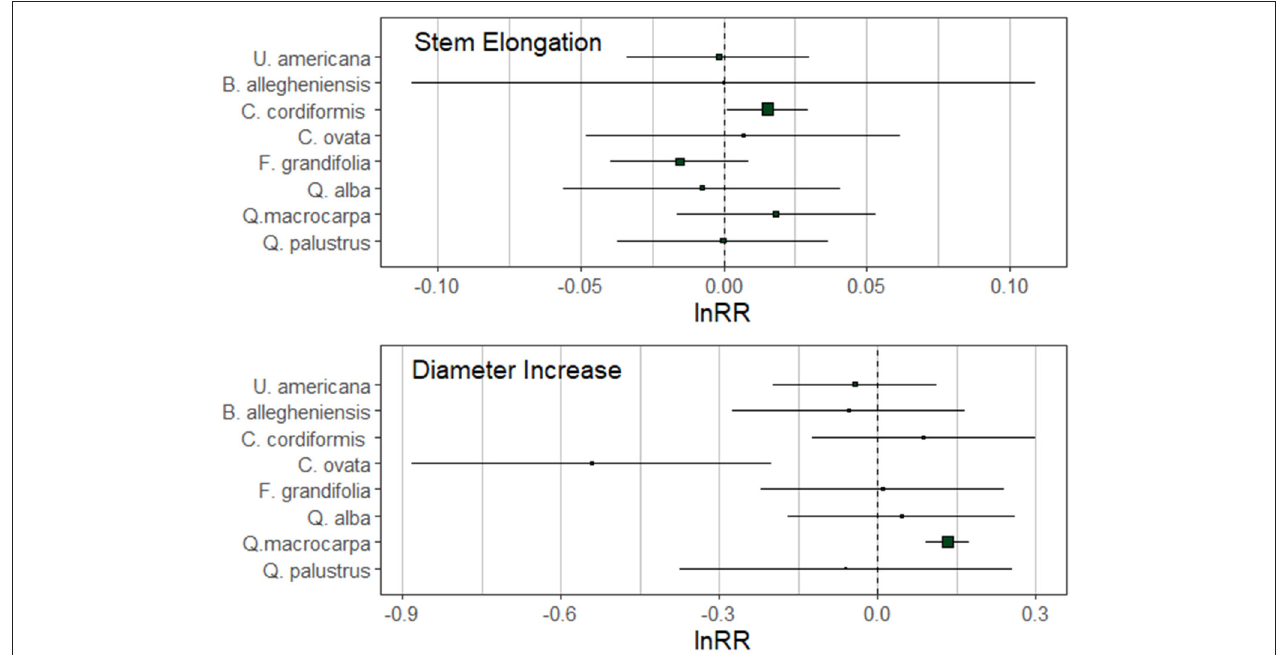
FIGURE 2 | Natural log-response ratios (lnRR) for stem elongation and diameter increase at the conclusion of the second growing season. Mean lnRR and boundaries of the 95% confidence intervals are represented on the figure. Positive plant-soil feedbacks have positive values and negative plant-soil feedbacks have negative values of lnRR.